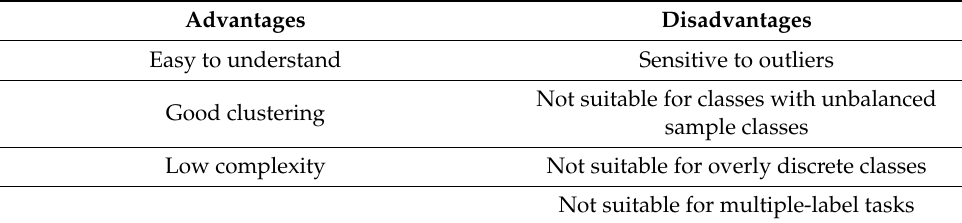
Table 4. The advantages and disadvantages of